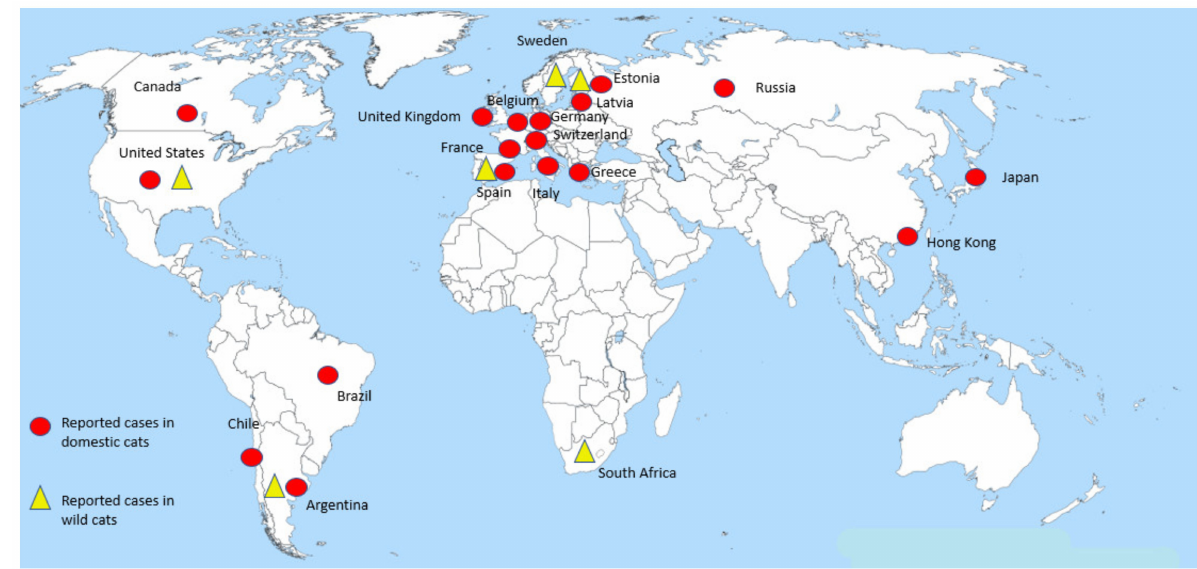
Figure 2. Distribution of cases of SARS-CoV-2 reported in domestic and wild cats worldwide . Red circles denote cases in domestic cats reported by country. The virus has been detected in at least three different continents (the Americas, Europe and Asia) in these animals. Yellow triangles denote cases in captive wild felines which have been reported in the Americas, Europe and